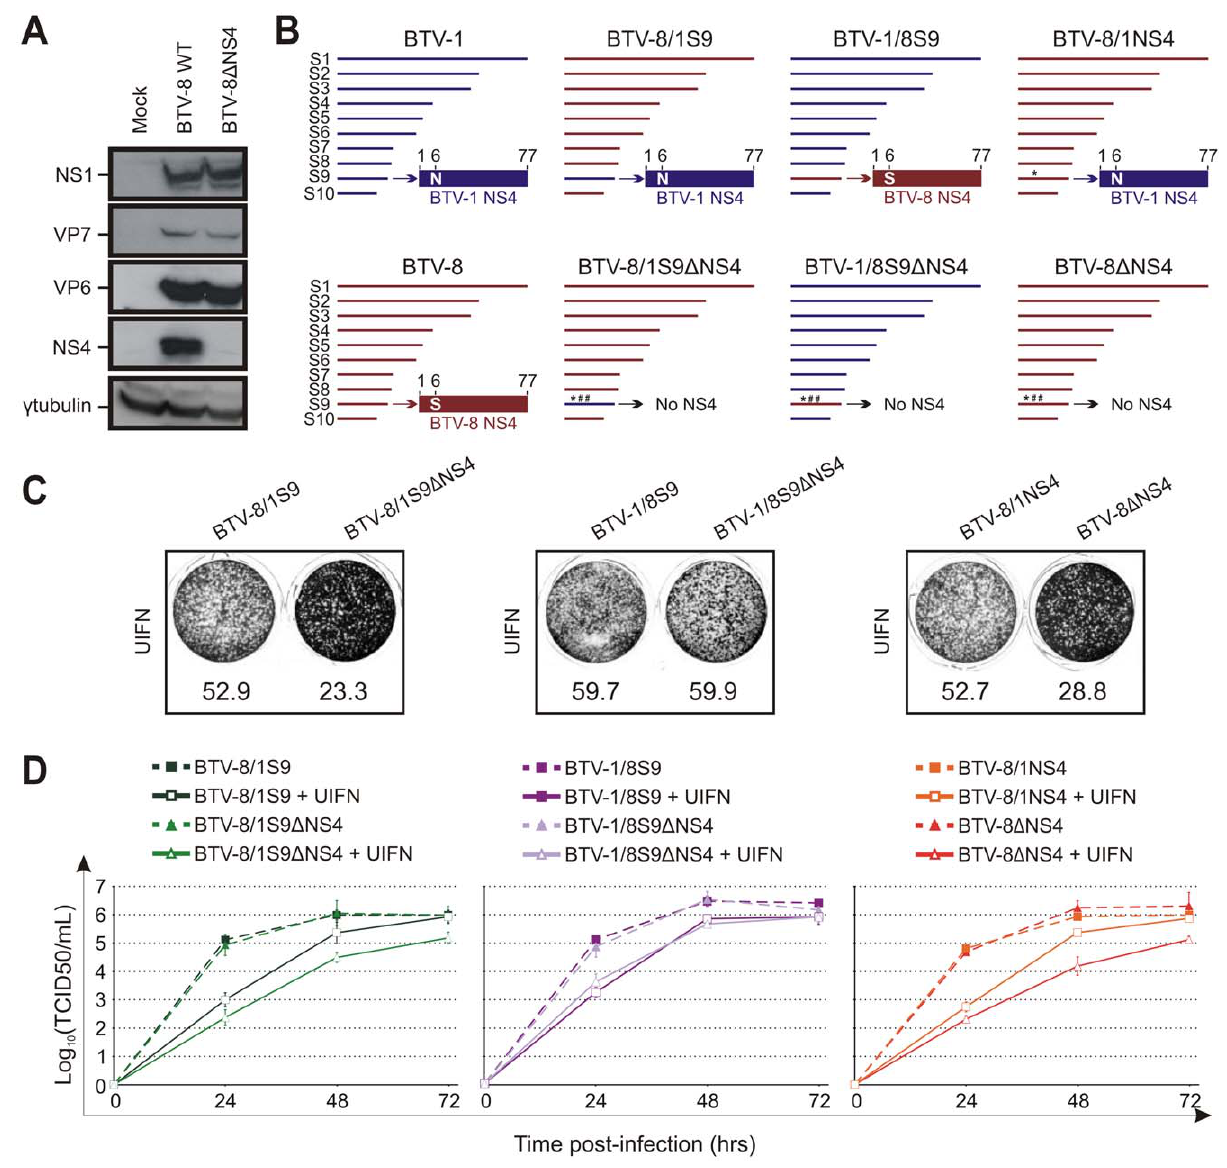
Figure 8. The NS4 of BTV-1 displays similar biological properties to the homologous BTV-8 protein. (A) Western blotting of cellular extracts (lysate) of CPT-Tert cells infected with BTV-8 wt or BTV-8 D NS4 at a MOI of 0.01. Cells were analyzed 24 h post-infection and blots were incubated with antisera against NS1, VP7, VP6, NS4 and c -tubulin as indicated. (B) Schematic diagram of the BTV-8/BTV-1 reassortants and mutants used in this study. Note that BTV1 and BTV8 segments/proteins are coloured in blue and red, respectively. * indicates a point mutation, while # indicates the introduction of a stop codon in the NS4 ORF. (C) CPT-Tert cells were treated with 1000 AVU/ml of Universal IFN for 20 h prior, and 2 h after, being infected by the recombinant viruses indicated in the panel using a MOI of 0.01. Cell monolayers were stained 72 h post-infection using crystal violet. Values indicated below each well correspond to the relative quantification of the disrupted monolayer using Image-Pro Plus (MediaCybernetics, Inc.). (D) CPT-Tert cells were treated (solid line) or mock treated (dashed line) with 100 AVU/ml of Universal interferon (UIFN) for 20 h prior and 2 h after being infected by the viruses indicated in the panel. Cells were infected at a MOI of 0.01. Supernatants were collected at 24, 48 and 72 h after infection, and then titrated on BSR cells by limiting dilution analysis and virus titers expressed as log 10 (TCID 50 /ml). In parallel, each virus preparation was also re-titrated by limiting dilution analysis to control that equal amounts of input virus was used in each experiment. This experiment was performed two times, each time in